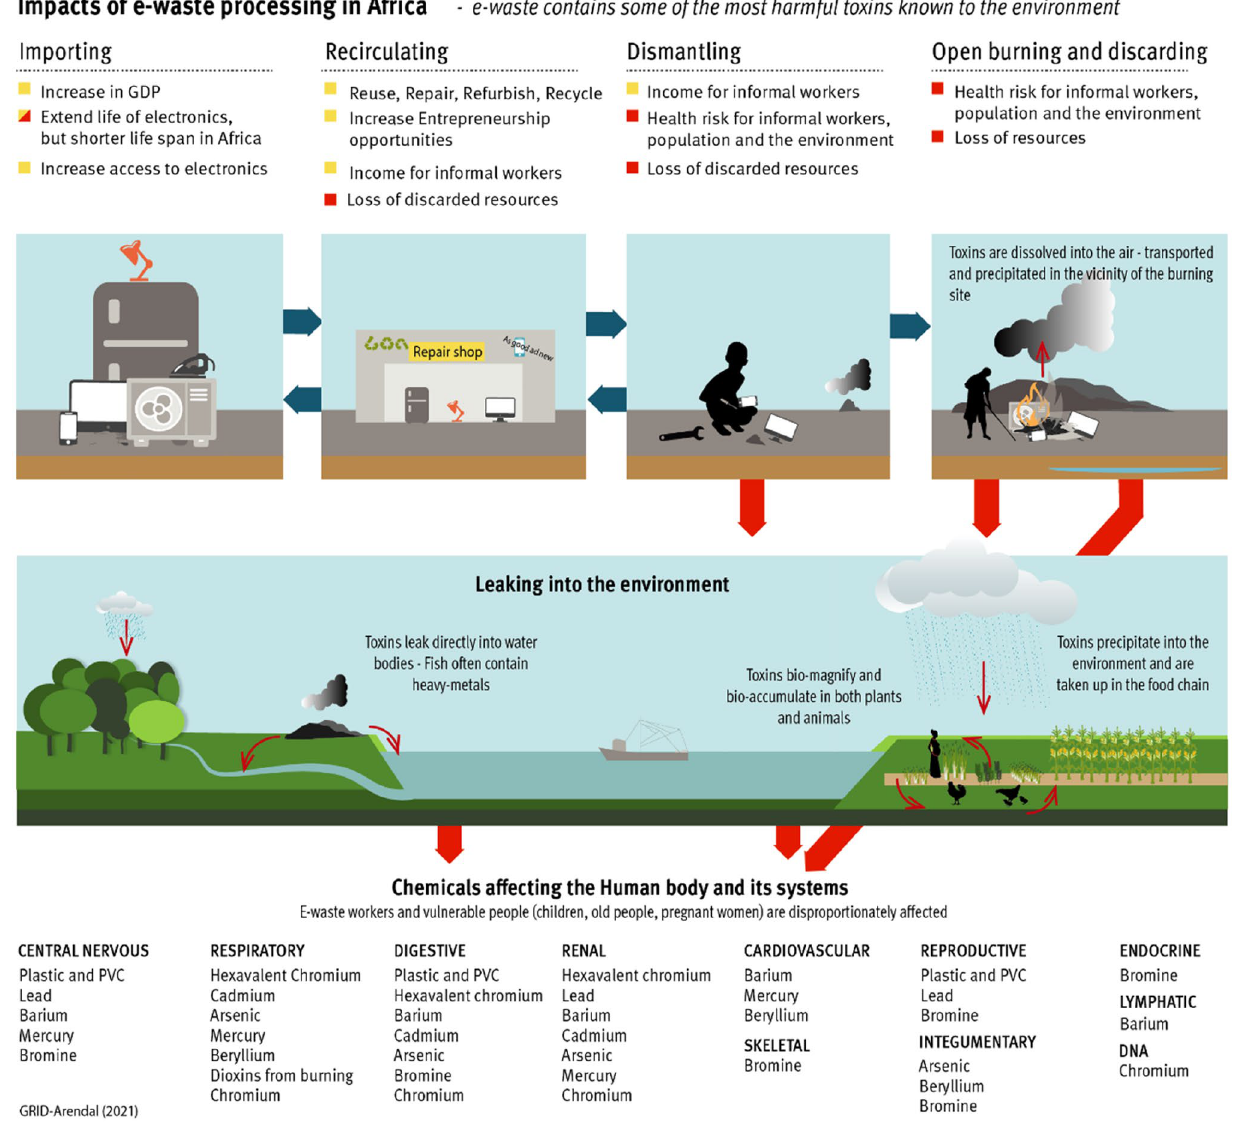
Fig. 2 Impacts of e-waste processing in